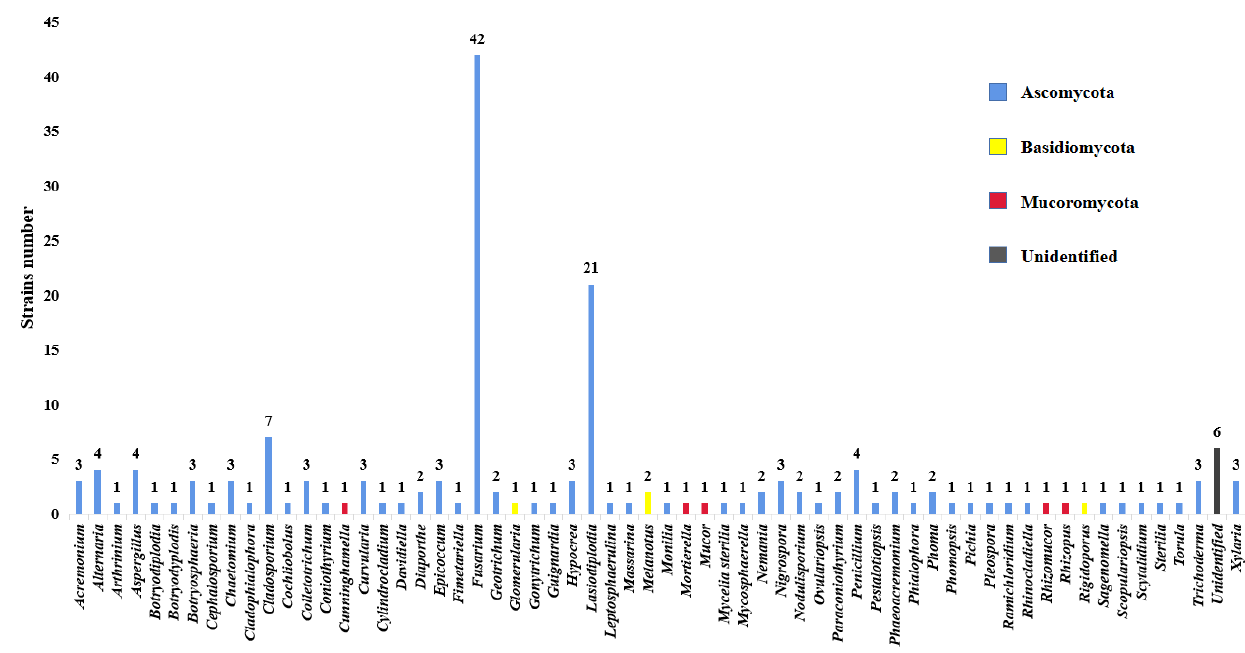
Figure 2. Endophytic fungi isolated from various parts of agarwood-producing trees. Table 1. Endophytic fungi isolated from agarwood-producing trees. “Y” indicates an ability of this strain to induce the formation of agarwood resin, “N” indicates that this strain has not been tested to induce the formation of agarwood resin in the given study; “N/A” indicates that no information available (The table is arranged according to the time of publication).